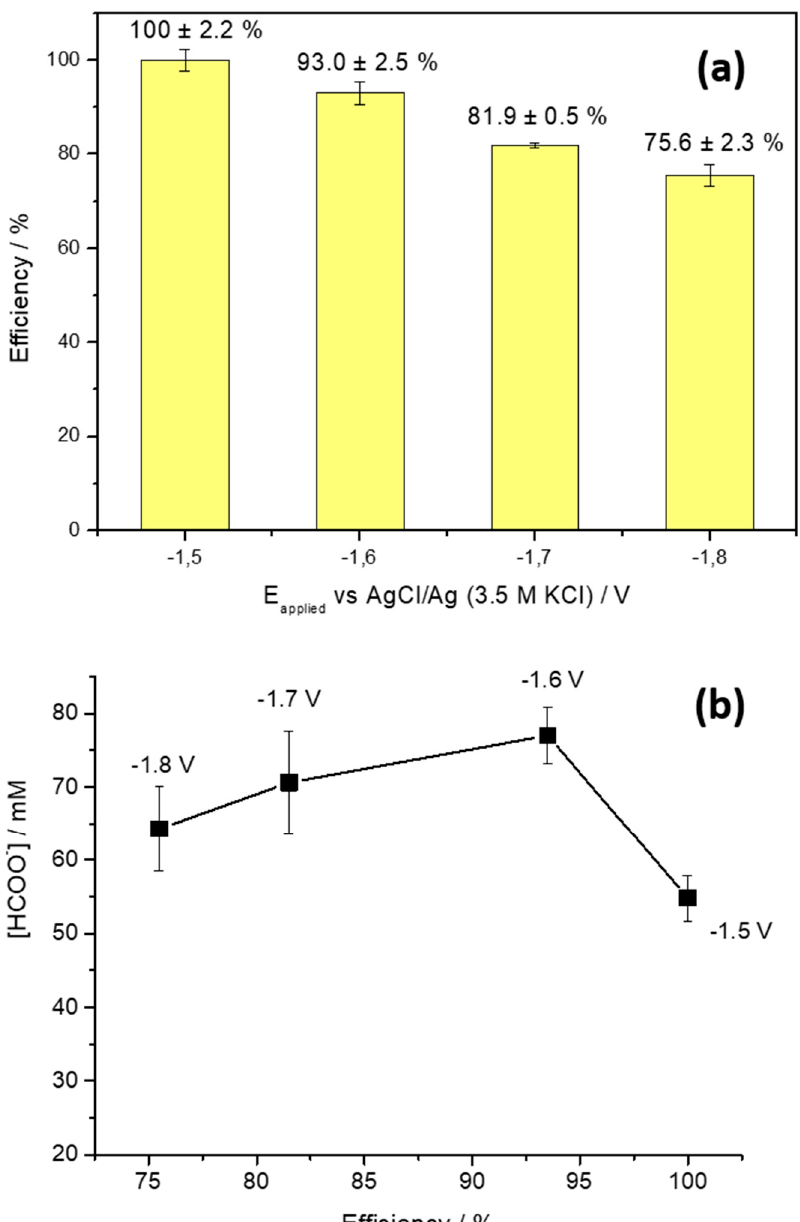
Figure 4. ( a ) Faradaic efficiency for formate production at different controlled potential from − 1.5 to − 1.8 V. Electrolysis time: 3 h. ( b ) Formate concentration produced after 3 h of electrochemical reduction of CO 2 at different controlled potentials as a function of Faradaic efficiency.